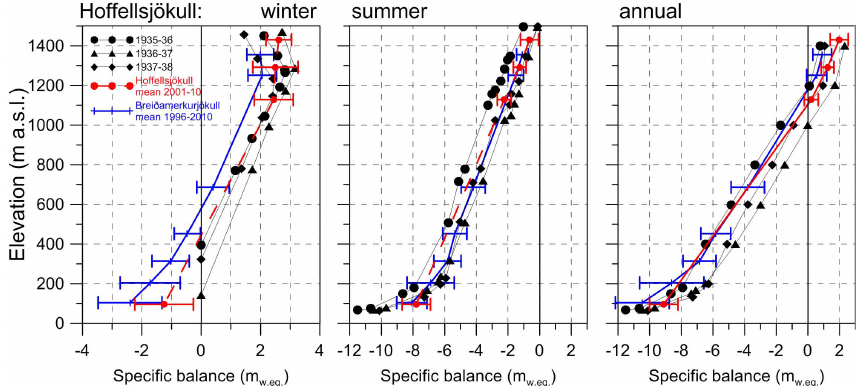
Fig. 5. Winter, summer and annual balance measured at Hoffellsjökull and Breiðamerkurjökull. Measurements from the 1930s expedition (at the lowest stakes only annual balance was measured and therefore winter balance set to zero) are shown with black symbols. The red dots show the average and standard deviation of the mass balance measurements in the period 2001–2010 at the two stakes on Hoffellsjökull and the two stakes close to the ice divide. The blue dots are similar measurements from Breiðamerkurjökull that have been used to determine the elevation dependency of mass balance when computing the mean specific mass balance in Table 1 (see Fig. 1 for location of the stakes).